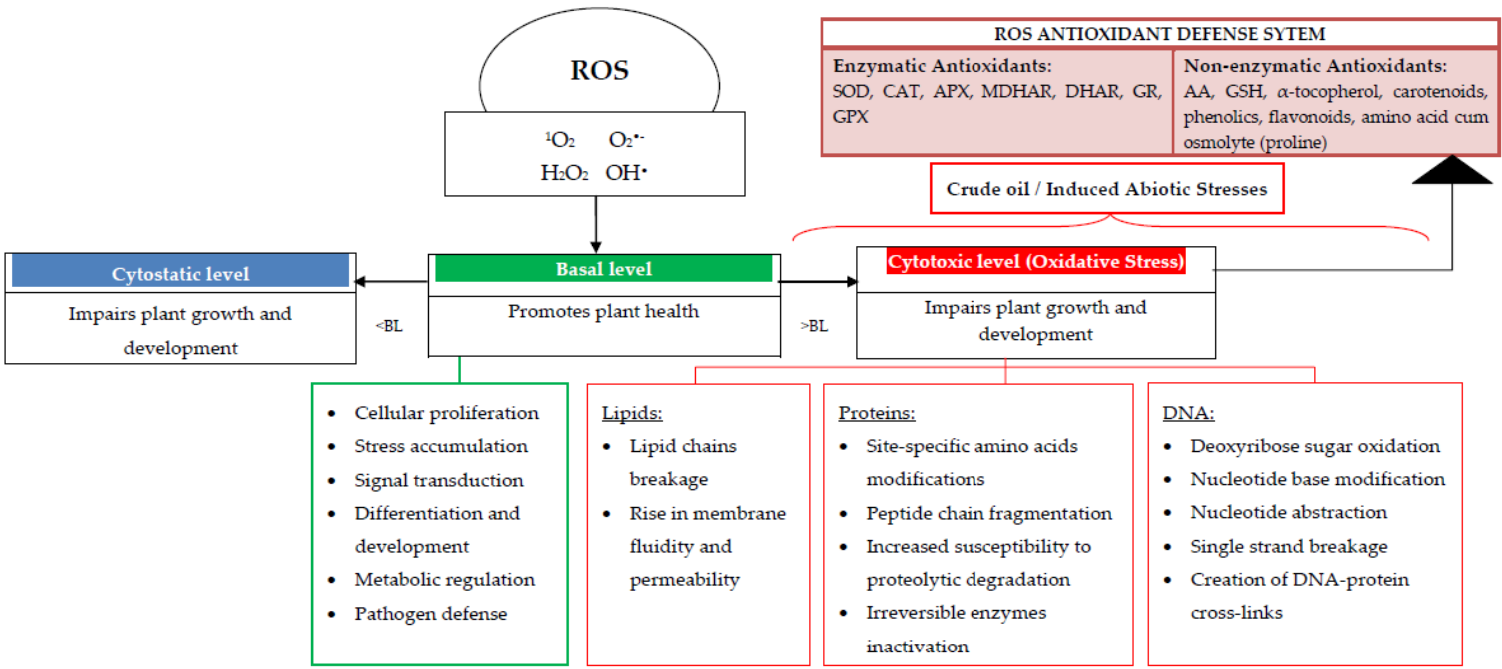
Figure 11. Connection between the impact of the various levels of ROS on plants and the antioxidant system. ROS = reactive oxygen species; BL = basal level; DNA = deoxyribonucleic acid; SOD = superoxide dismutase, CAT = catalase, APX = ascorbate peroxidase, MDHAR = monodehydroascorbate reductase, DHAR = dehydroascorbate reductase, GR = glutathione reductase, GPX = guaiacol peroxidase; AA = ascorbic acid, GSH = glutathione. Adapted from: Reference [115,139,142].